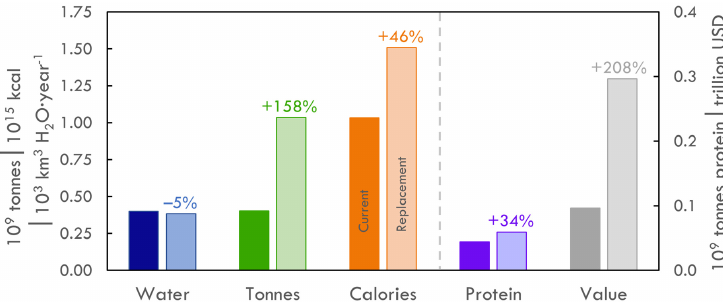
Figure 1. Benefits of optimized crop distribution in terms of water use, production, and economic values.